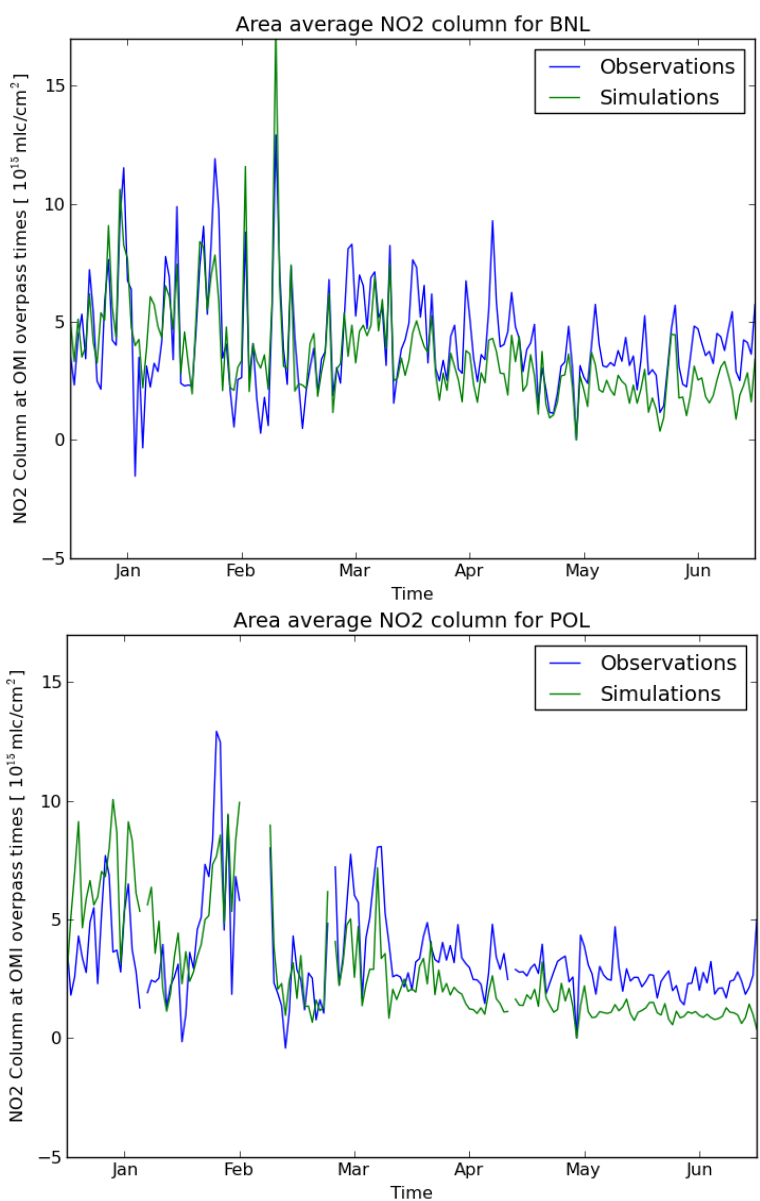
Figure 4. Time series comparison of OMI retrieved and simulated NO regional average for the Benelux ( top ) and Poland ( bottom ) for the first half-year of